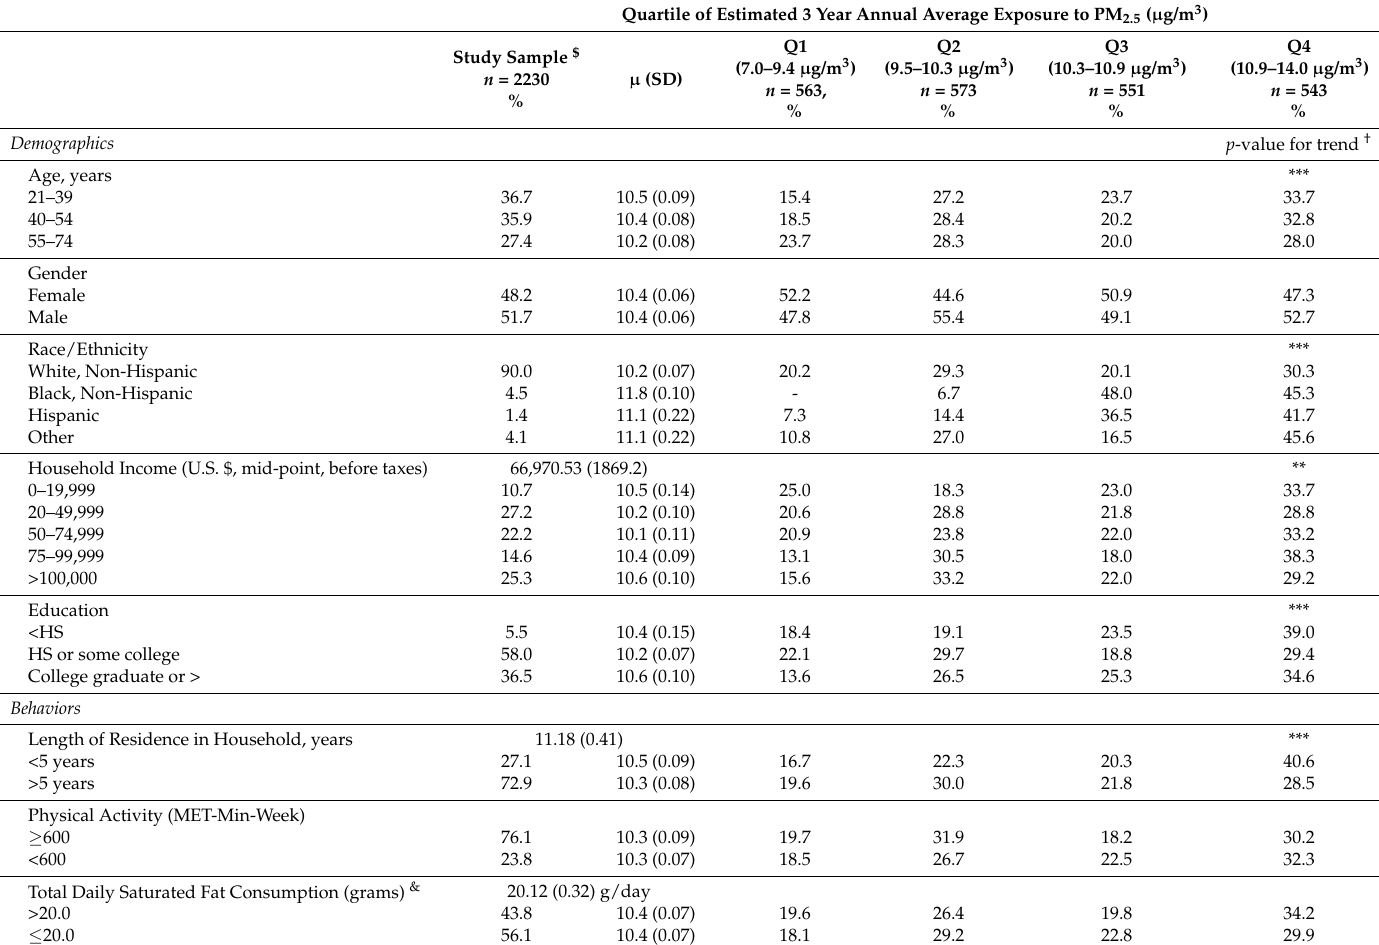
Table 1. Study population characteristics, proportion of population by quartiles of 3-year annual average PM 2.5